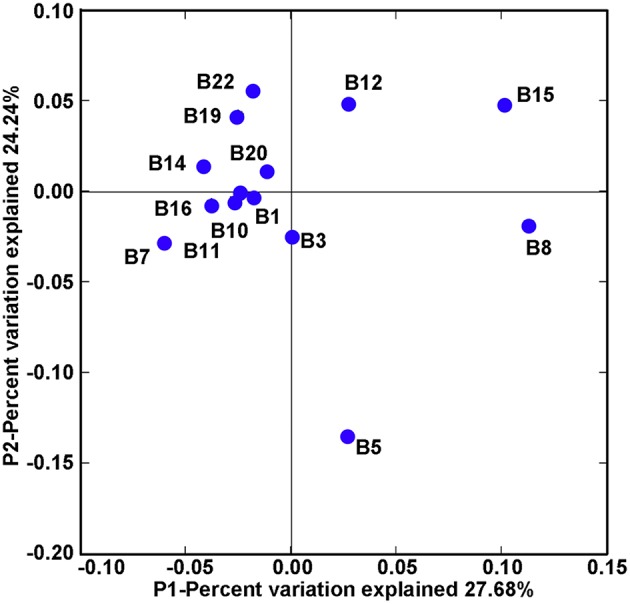
PCoA ordination diagram of the Bohai Sea sediment nifH-harboring microbial assemblages. This diagram was produced by using the Fast UniFrac weighted and normalized PCoA method with the use of the NifH protein sequence data. The P1 and P2 show the percent variations of the diazotroph assemblages explained by the first two principal coordinates.